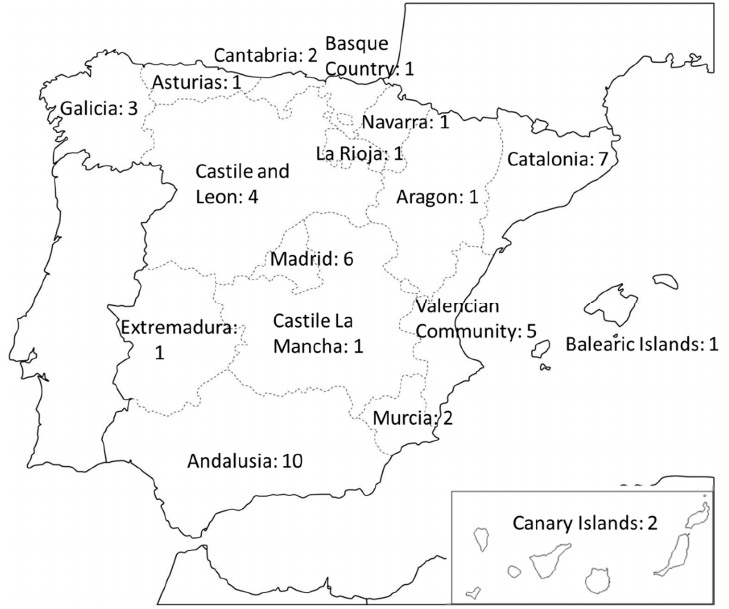
Figure 1. Distribution of Spanish public universities. Source: Authors.